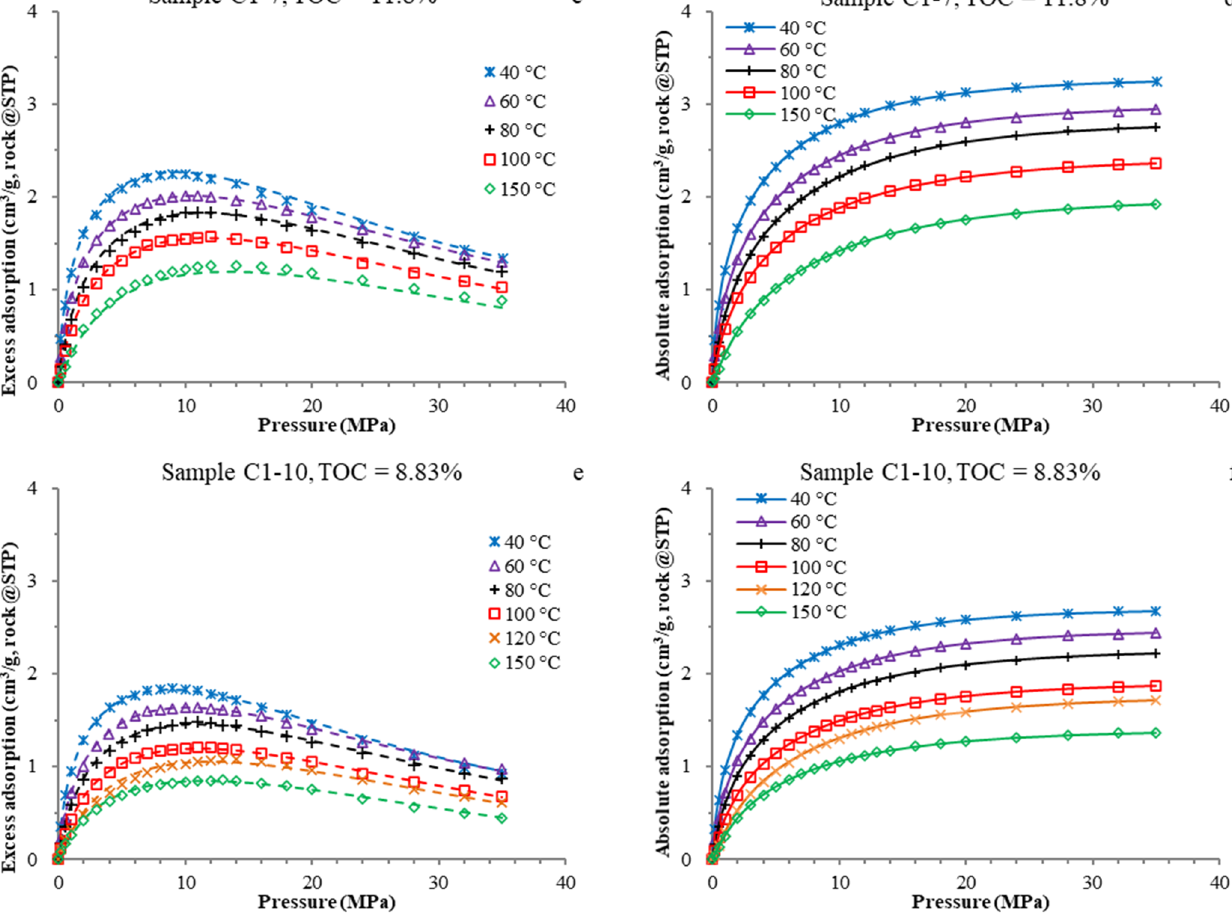
Figure 3. Measured and fitted excess adsorption isotherms against equilibrium pressure ( a , c , e ) and their absolute adsorption isotherms calculated by the SDR model ( b , d , f ) at various temperatures for the three selected samples.